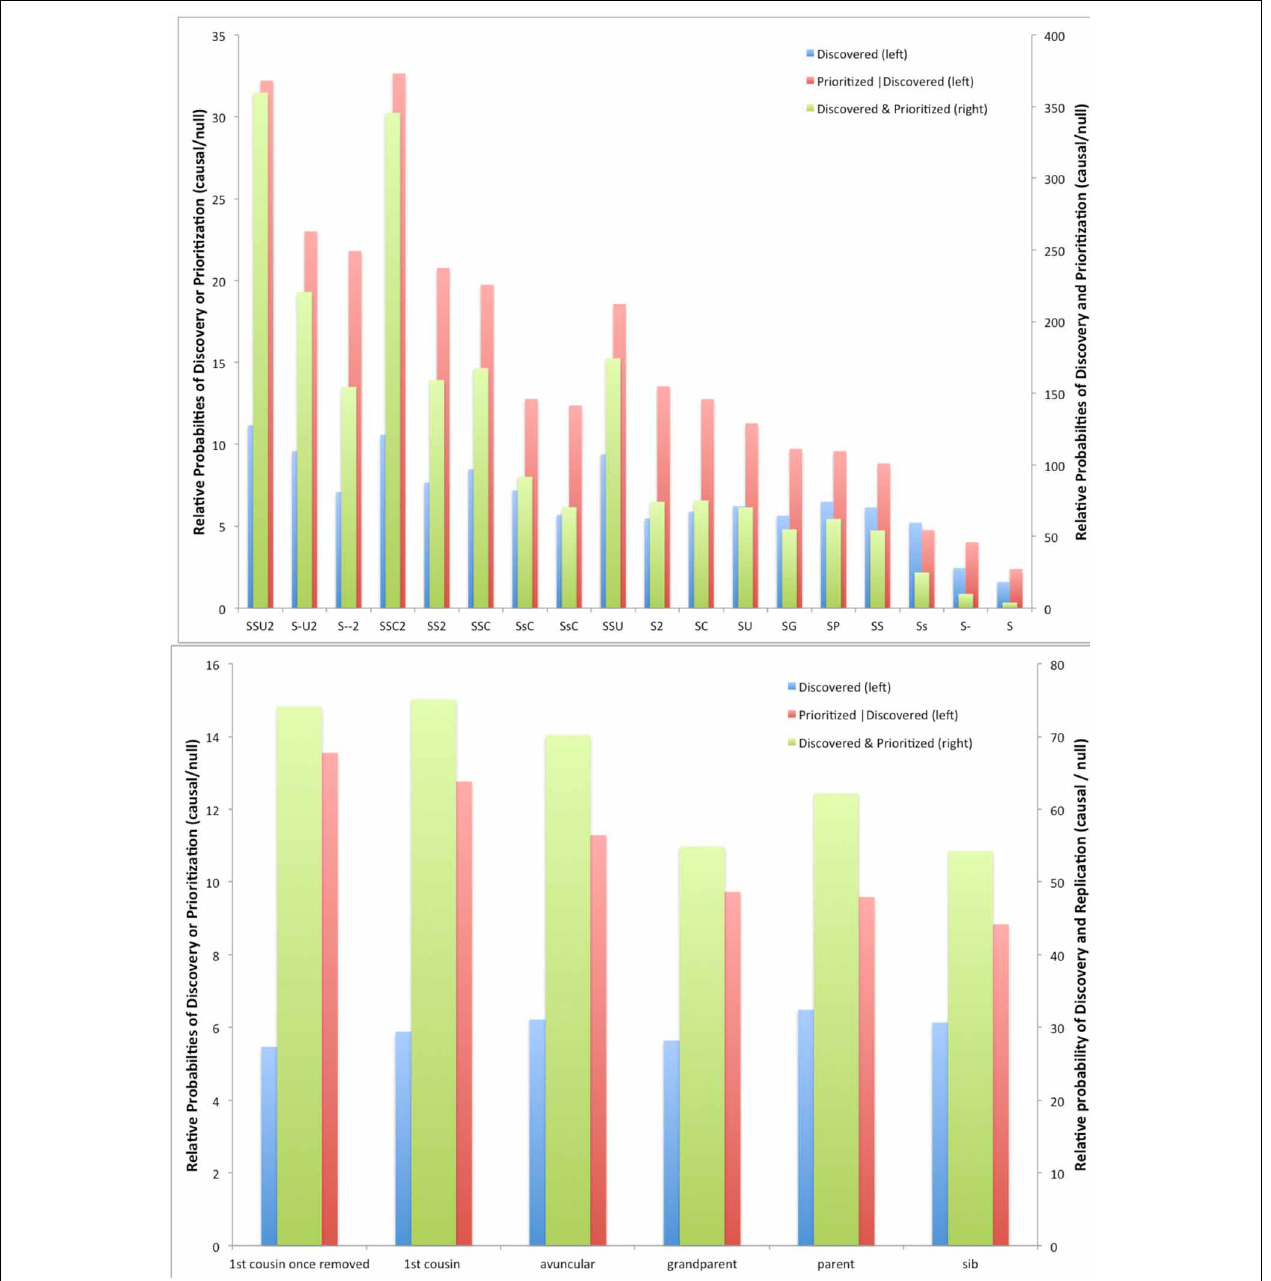
FIGURE 2 | Relative probabilities of discovery, prioritization, and both between causal vs. null variants for different criteria for selecting members for sequencing in simulated 11-member pedigrees with at least 4 affected members. Top panel , all designs; bottom panel , detail for